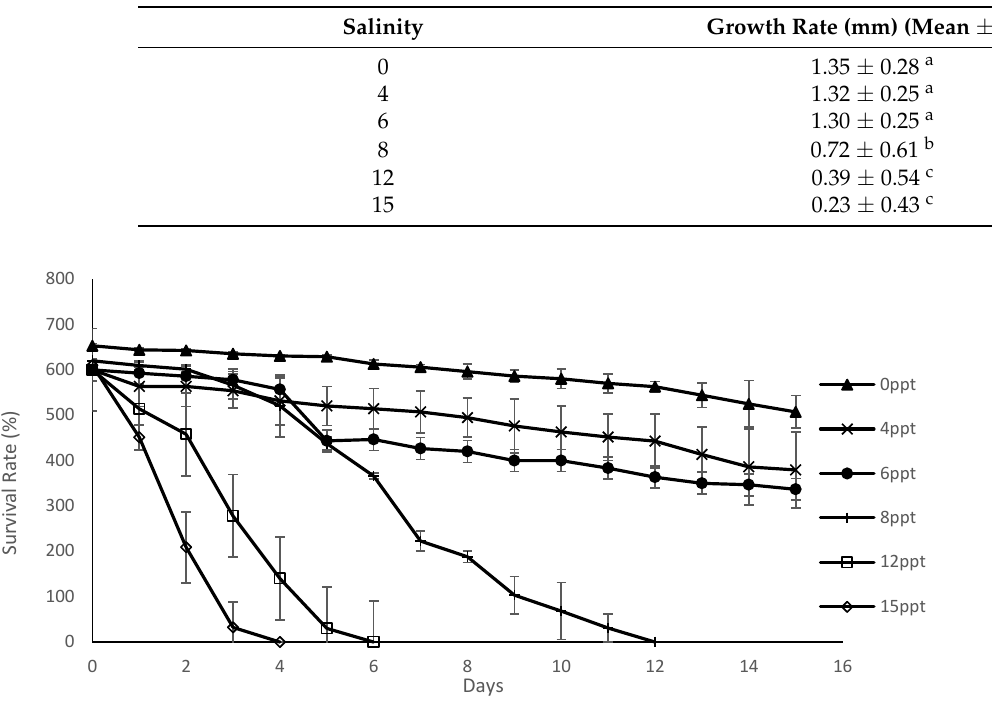
Figure 3. The survival rate of M. macrocopa for different salinity treatments. Table 3. Growth rate of M. macrocopa on different ranges of salinity. All values are mean ± standard deviation ( n = 3). The different small letters indicate a significant difference between different salinity levels ( p < 0.05).